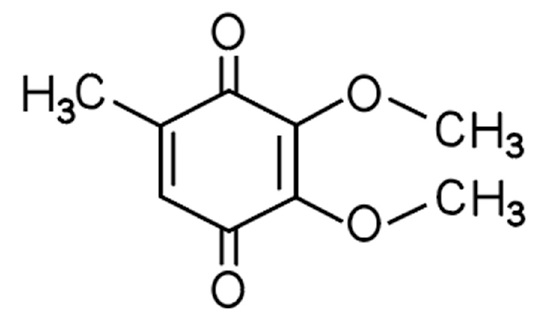
Figure 1. The chemical structure of CoQ 0 .